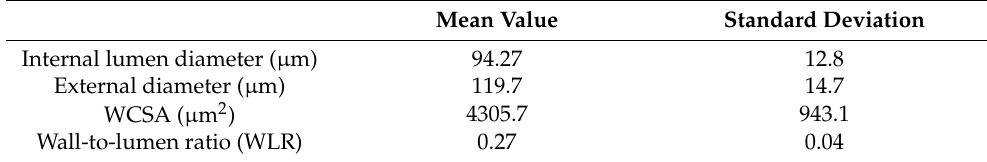
Table 2. Retinal arterioles parameters measured by adaptive optics